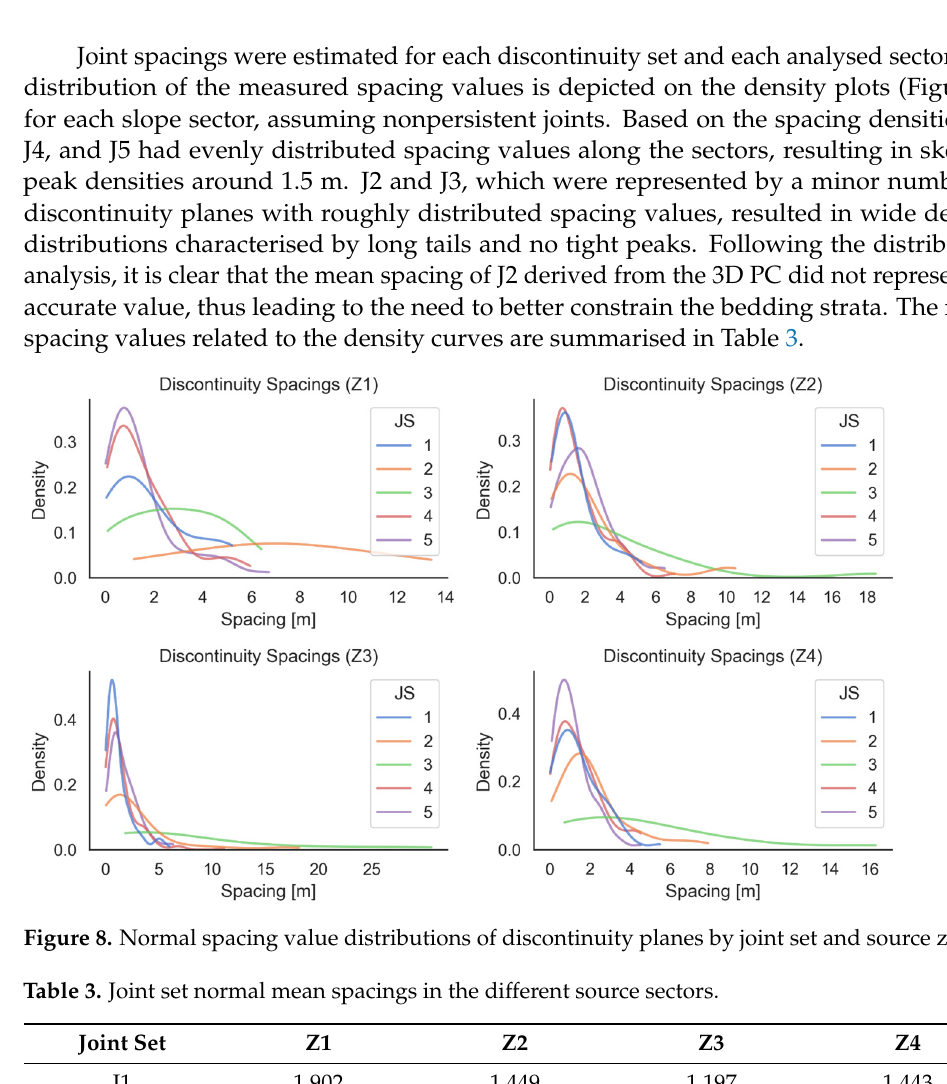
Figure 7. Stereoplot of discontinuity planes extracted utilizing DSE software at the selected source sectors. Table 2. Principal orientations of discontinuities extracted from source sectors in the 2019 SfM point cloud.